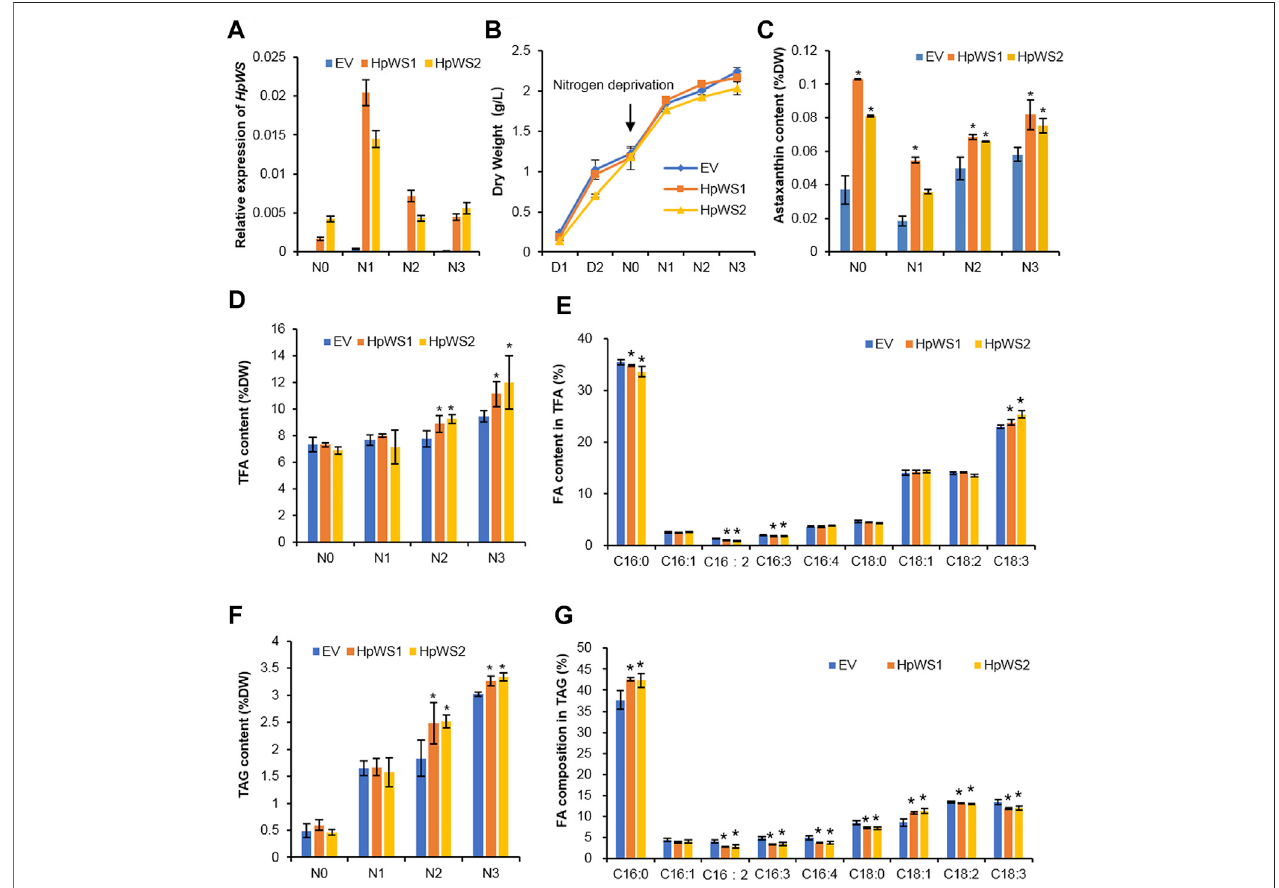
FIGURE 5 | Growth and lipid production in Chlamydomonas reinhardtii BKT5 transformants overexpressing HpWS under nitrogen-replete and nitrogen-depleted conditions. (A) Expression of HpWS in the C. reinhardtii transformants. (B) Dry weight. (C) Astaxanthin content. (D) TFA content. (E) Fatty acid composition in TFA after 3 daysundernitrogen deprivation. (F) TAGcontent. (G) Fattyacidcomposition inTAGafter2 days undernitrogen deprivation. TFA, totalfatty acid;FA, fatty acid.EV, C. reinhardtii BKT5harboringpChamy_4 vector. HpWS1and HpWS2 aretwoindividual C.reinhardtii transformantsoverexpressingHpWS.D, cultureundernitrogen repletion; N, culture under nitrogen deprivation. Data are expressed as mean ± SD, n (cid:1) 4. * p < 0.05 (Student ’ s t -test).